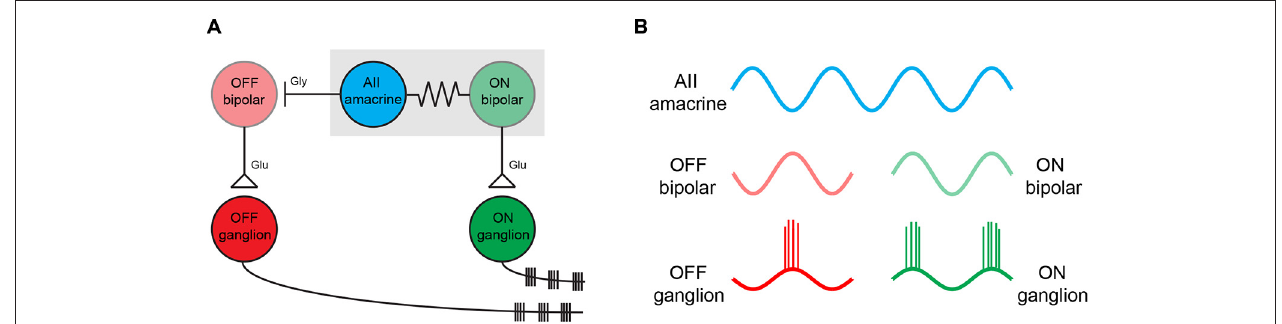
cells with glycine (labeled as gly). ON and OFF bipolar cells activate ON and OFF ganglion cells, respectively, via glutamate release (labeled as glu). Neighboring ON and OFF ganglion cells oscillate out of phase with one another (B) . Oscillation in the AII amacrine/ON cone bipolar cell network interact with multiple types of amacrine cells and result in altered dynamics in the ∼ 30 types of ganglion cell microcircuits (not